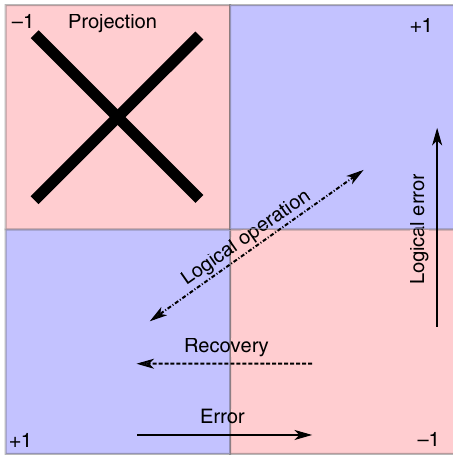
Fig. 2 Cartoon schematic of error correction vs error projection in a stabilizer code. We sketch the quantum space as divided into the blue code space, de fi ned by + 1 eigenvalues of stabilizers and the red non-code space as de fi ned by having − 1 eigenvalues for some of the stabilizers. In traditional error correction, the stabilizers are measured, the errors decoded, and recovery operations are applied to return one to the code space. In error projection, we use projectors based on stabilizers to remove sections of non-code space using only simple Pauli measurements and post-processing. We can also combine this technique with forms of recovery, but the effective difference is depicted by the discarding of large parts of errant Hilbert